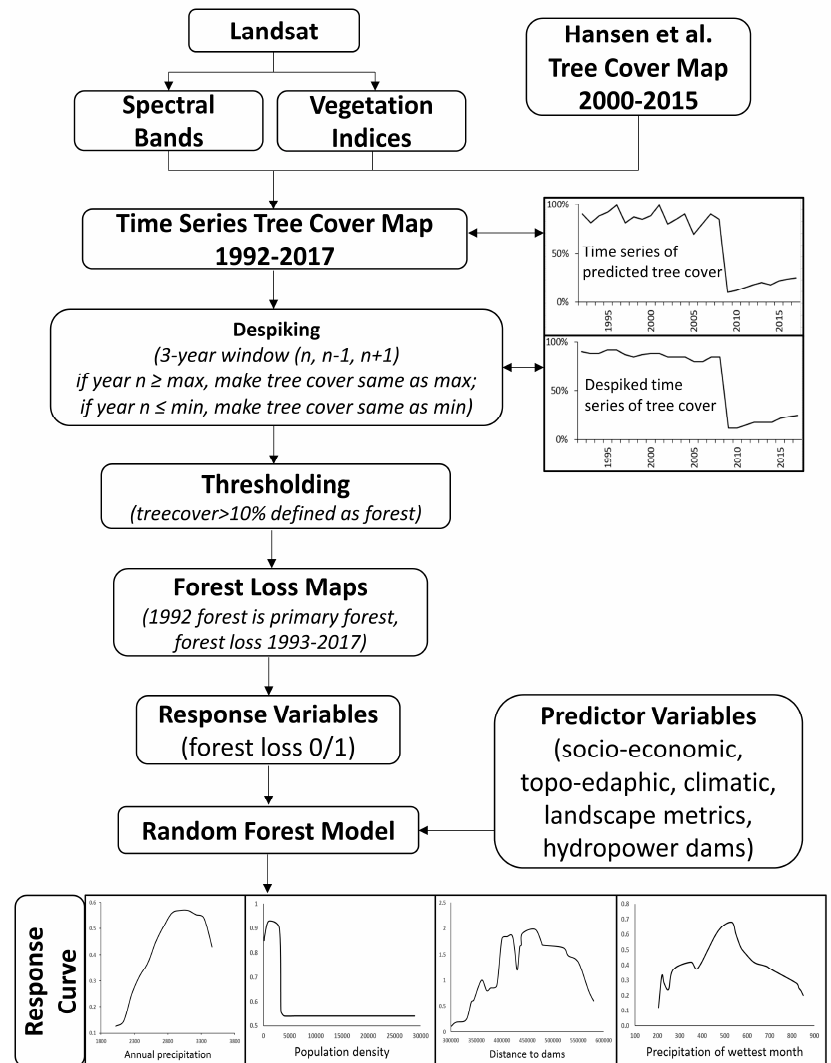
Figure 2. Diagram showing the methodology used in this